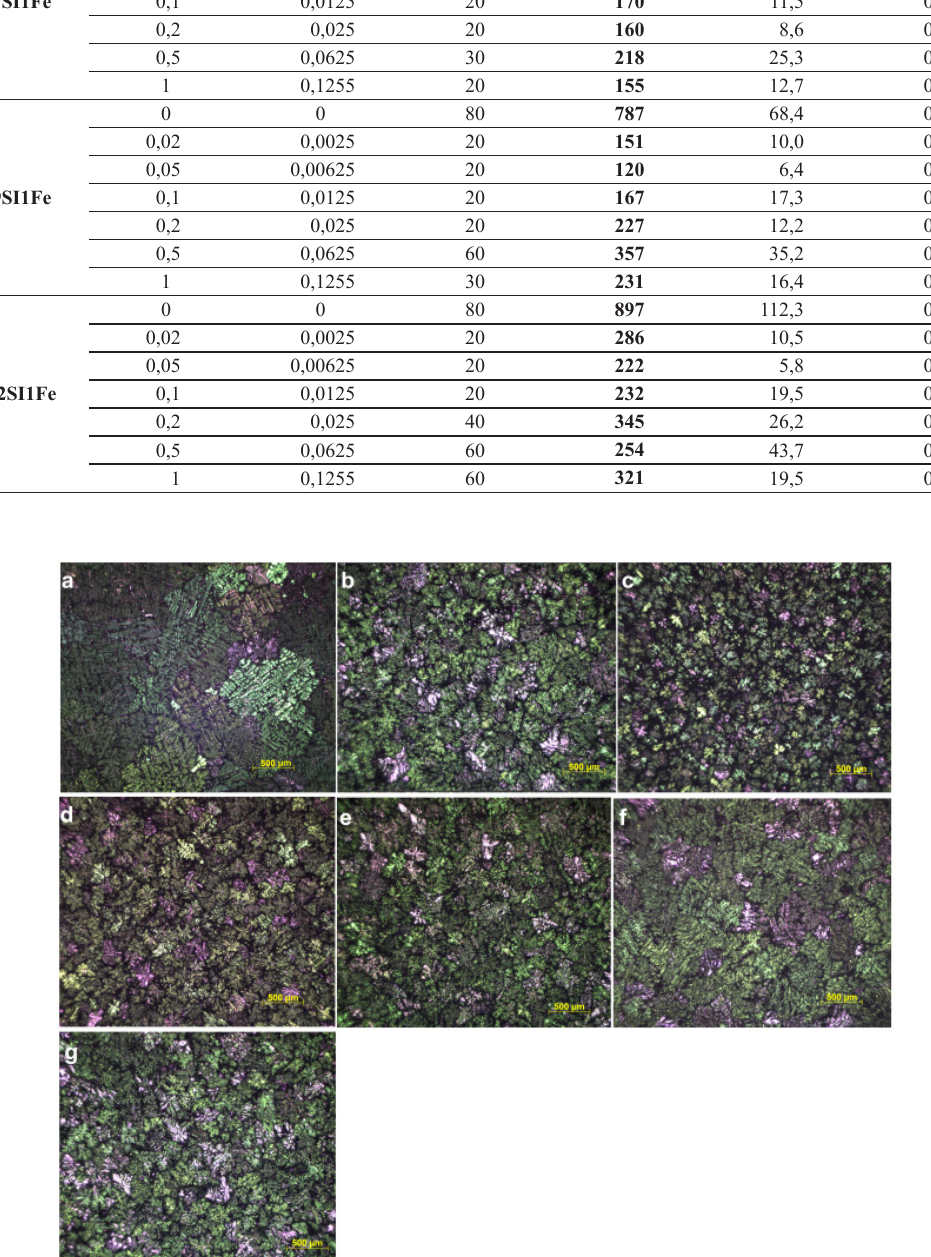
in Table 3 and plotted in Figure 8. The differences in grain size found in the samples were compared with the Al alloys’ stoichiometric